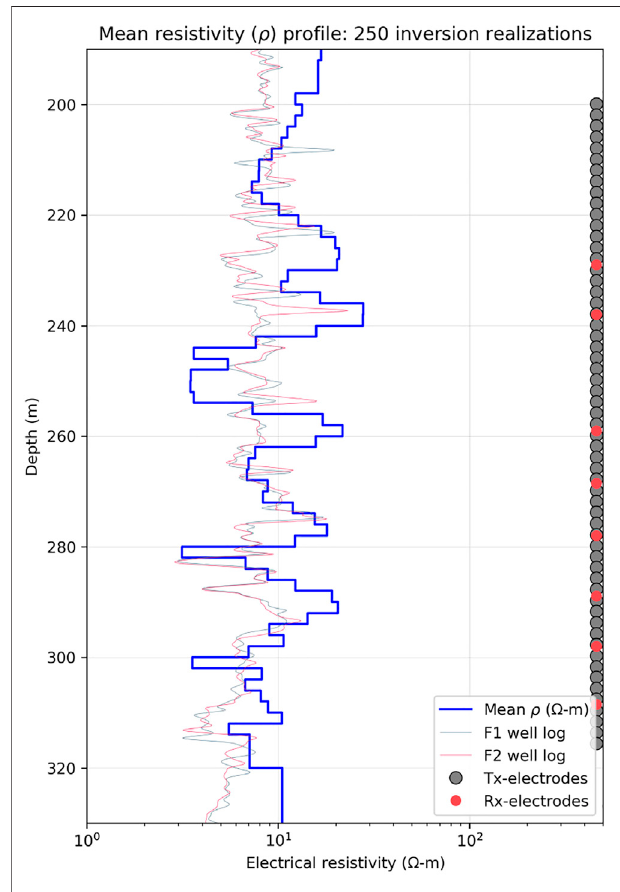
FIGURE9| 1D resistivitywell logs takenat CaMI.FRS. Also shown isthe mean model calculated from 250 fi eld-data inversion realizations. The fi nal mean 1D model comprises parameters for 66 layers of fi xed thickness. The vertical transmitter (grey) and receiver (red) electrode positions are projected onto the same line. Actual electrode distances are shown by Figure 1C